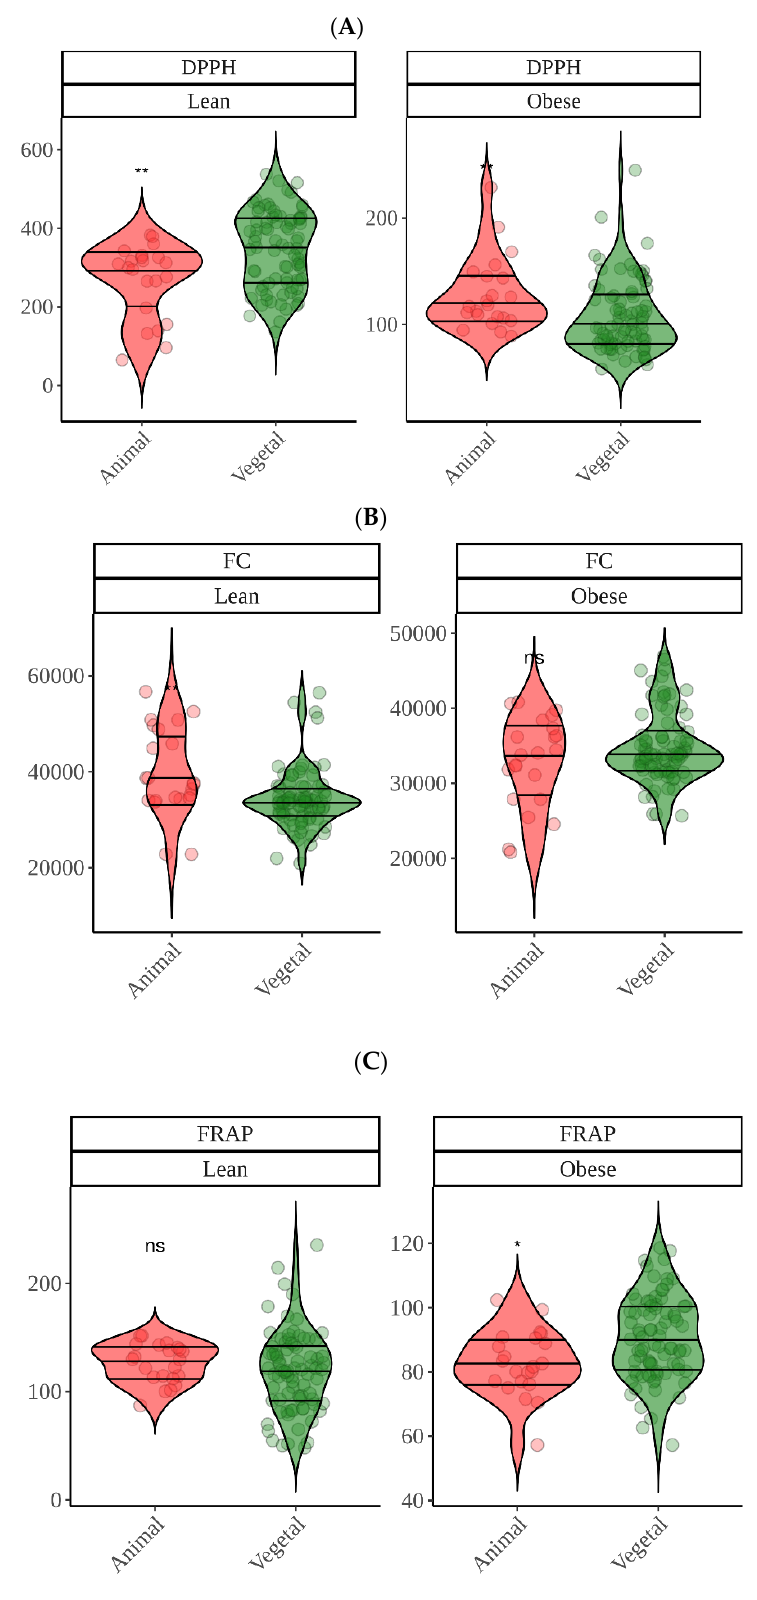
Figure 9. Antioxidant capacity released by lean or obese gut microbiota from plant-origin foods and animal products. ( A ) DPPH; ( B ) Folin–Ciocalteu; ( C ) FRAP. Statistical analysis was performed via Kruskal Wallis test. Comparisons were made using “Vegetal” as the reference group. Solid horizontal lines within shapes show 0.25, 0.5, and 0.75 quartiles. Statistic labels: *— p < 0.05, **— p < 0.01, ns—not significant. 5. Conclusions In conclusion, we evaluated a number of foods grouped in several categories. Cocoa products (dark chocolate and cocoa butter) displayed, overall, the highest antioxidant capacity. Antioxidant capacity of foods is released in a two-step process: first, some of this antioxidant capacity is released during digestion, and, usually, more antioxidant power released from those foods more easily digested whereas others, such as vegetables, release lower concentrations. Regardless, most of the antioxidant capacity is released during gut microbial fermentation, which could be due to two main reasons: for plant-origin foods (hard to digest due to lack of enzymes) most phytochemicals could be released only after gut microbes have broken down vegetal cells. Secondly, animal products that lack phytochemicals (they could have some due to animal feed) could exhibit their antioxidant power after amino acids are fermented into small phenolics but not before as larger peptides. Additionally, large differences were detected depending on whether foods were fermented with lean or obese fecal material. Overall, when using lean gut microbiota,